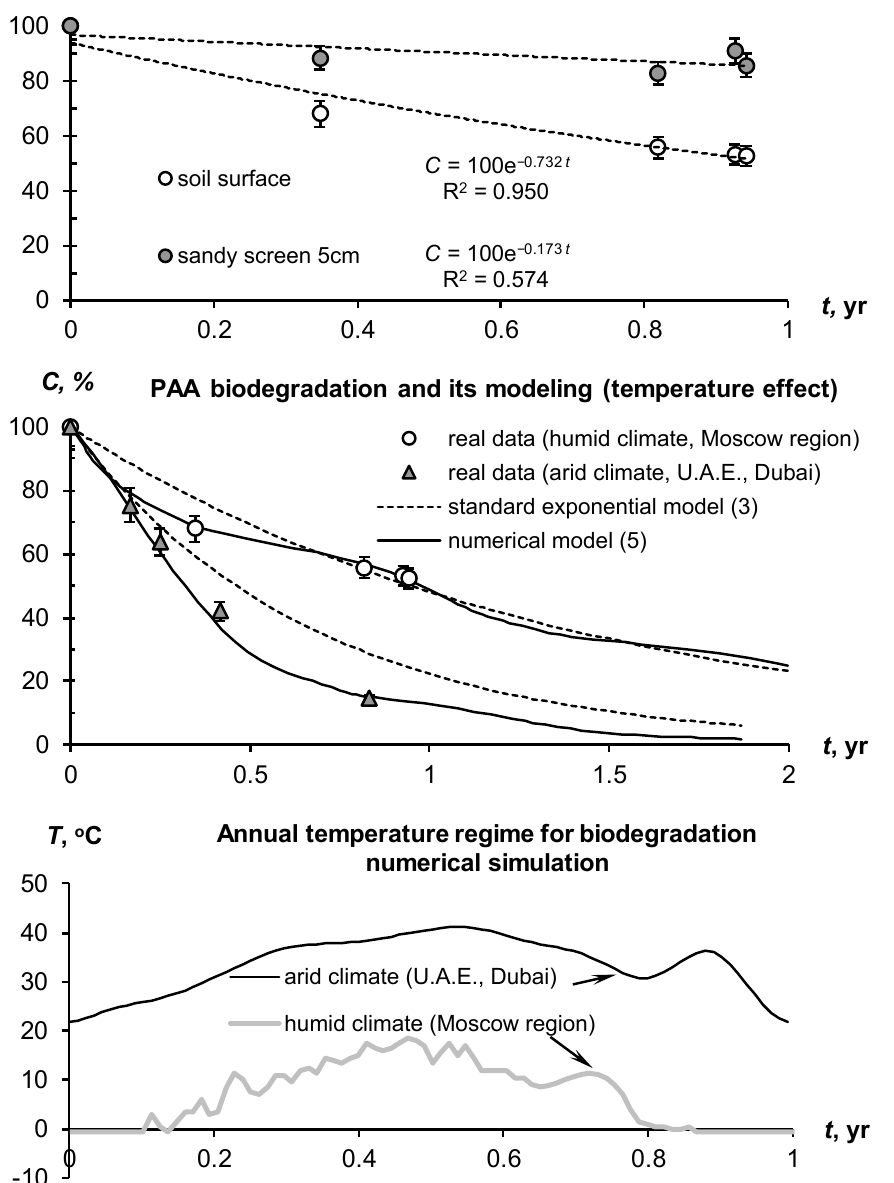
Figure 2. Biodegradation assessment and its computer modeling for PAA hydrogel. Used parameters for the exponential model (3): k = 0.732 ± 0.097 (soil surface); k = 0.173 ± 0.067 (5 cm depth); Used parameters for the exponential model (3): Parameters used for the numerical model (5): k 0 =1.5 yr − 1 , Q 10 =2, Tm = 20 (humid climate), Tm = 30 (arid climate).